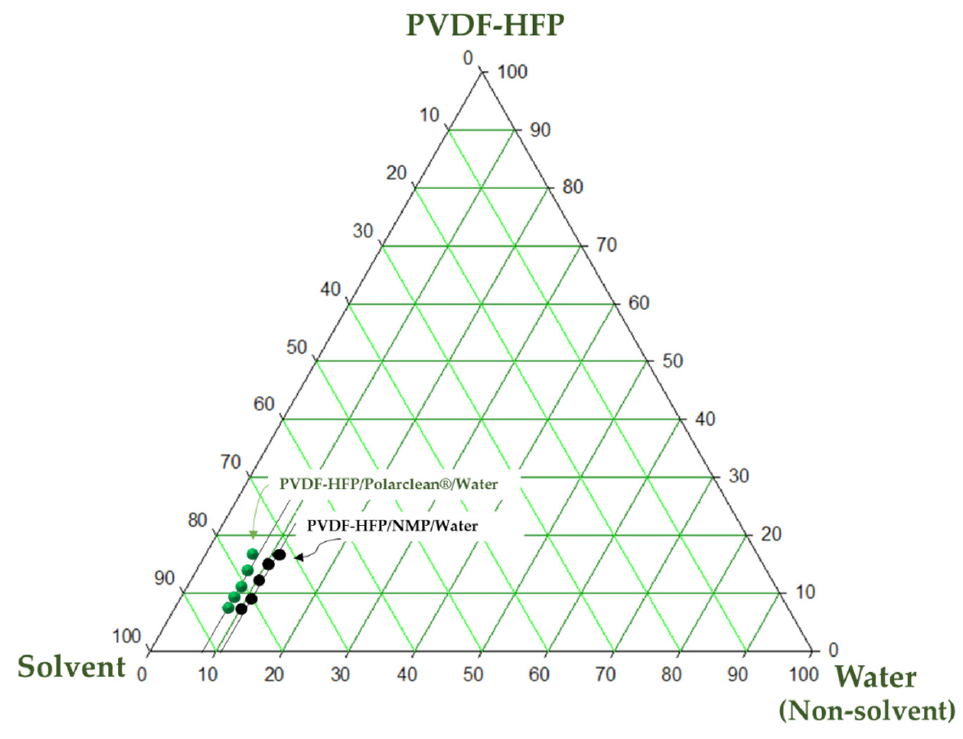
Figure 1. Ternary phase diagrams for PVDF-HFP/PolarClean/water and PVDF-HFP/NMP/water systems.